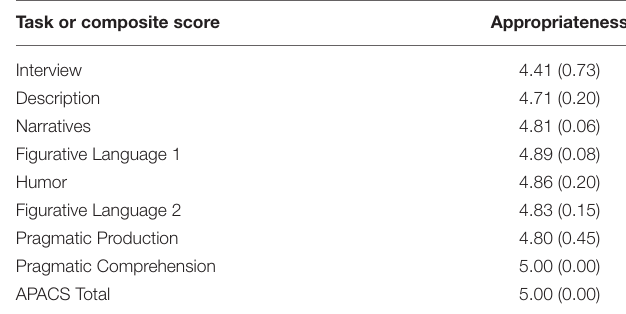
TABLE 5 | Results of factor analysis on APACS tasks. TABLE 6 | Content validity of